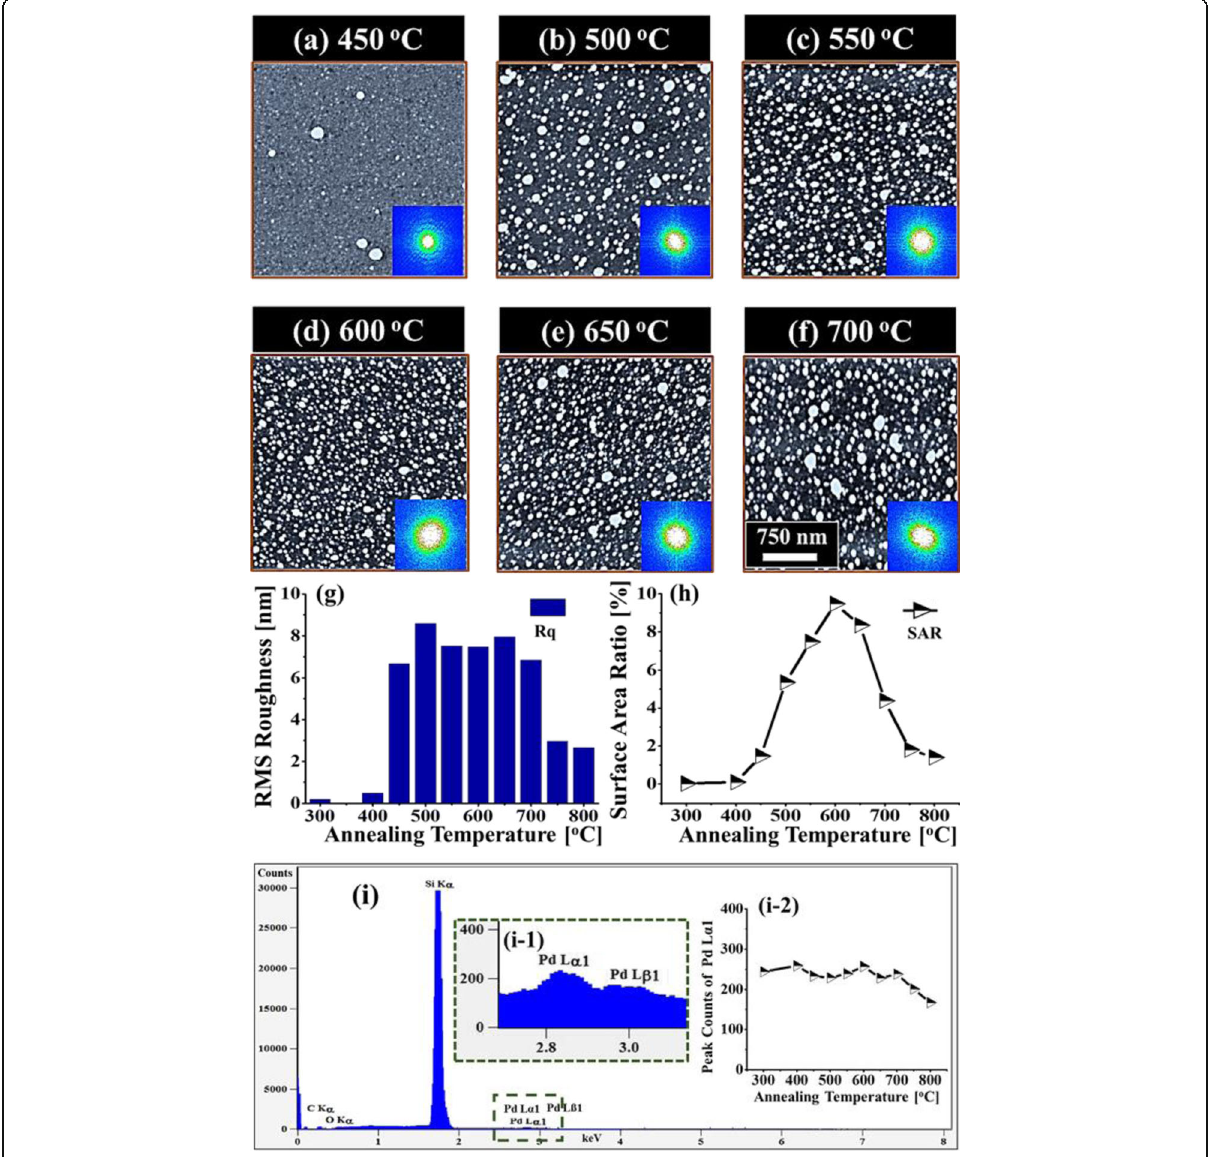
Fig. 5 Effect of the annealing temperature (AT) between 450 and 700 °C on the evolution of self-assembled Pd NPs with constant deposition amount of 5 nm annealed for 450 s. a – f AFM top-views of Pd NPs with the area of 3×3 μ m 2 , in which the insets represent the 2-D FFT power spectra. g – h Summary plots of Rq and SAR. i EDS elemental characterization. ( i-1 ) Enlarged spectrum showing Pd L α 1 and Pd Lß1 peaks. ( i-2 ) Summary plot of